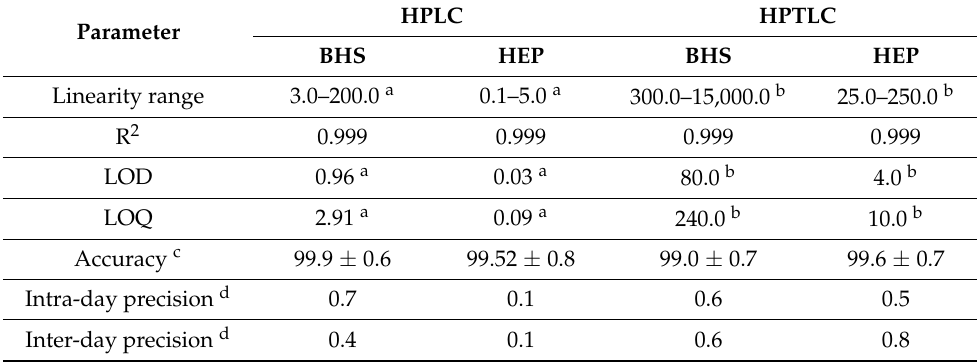
Table 2. Linearity and regression results for the determination of BHS and HEP using the proposed methods.